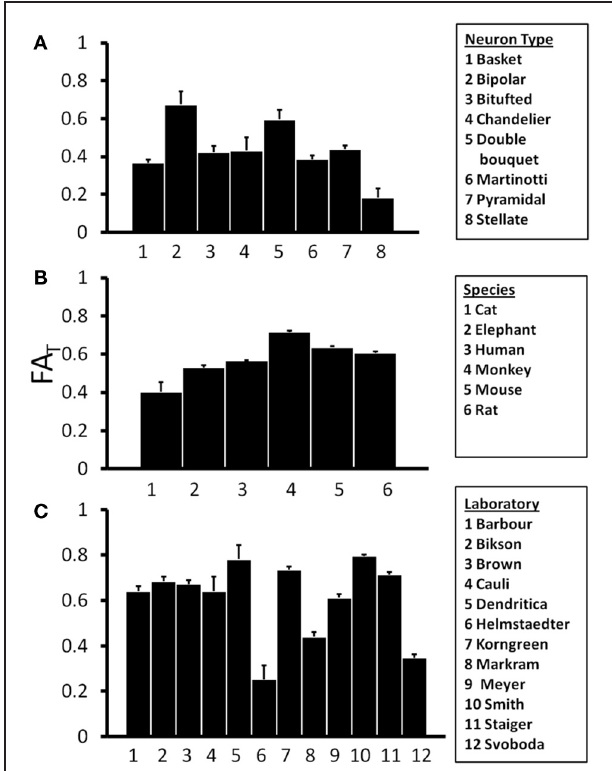
FIGURE 4 | One-Way Analysis of Variance (ANOVA) tests were performed to determine the effects of independent variables Neuron Type (A), Species (B), and Laboratory (C) on the orientation matrix fractional anisotropy, FA T . ANOVA results revealed significant effects of all three independent variables on FA T . This suggests that variability in FA T is potentially introduced by differences among neuron types, species, and